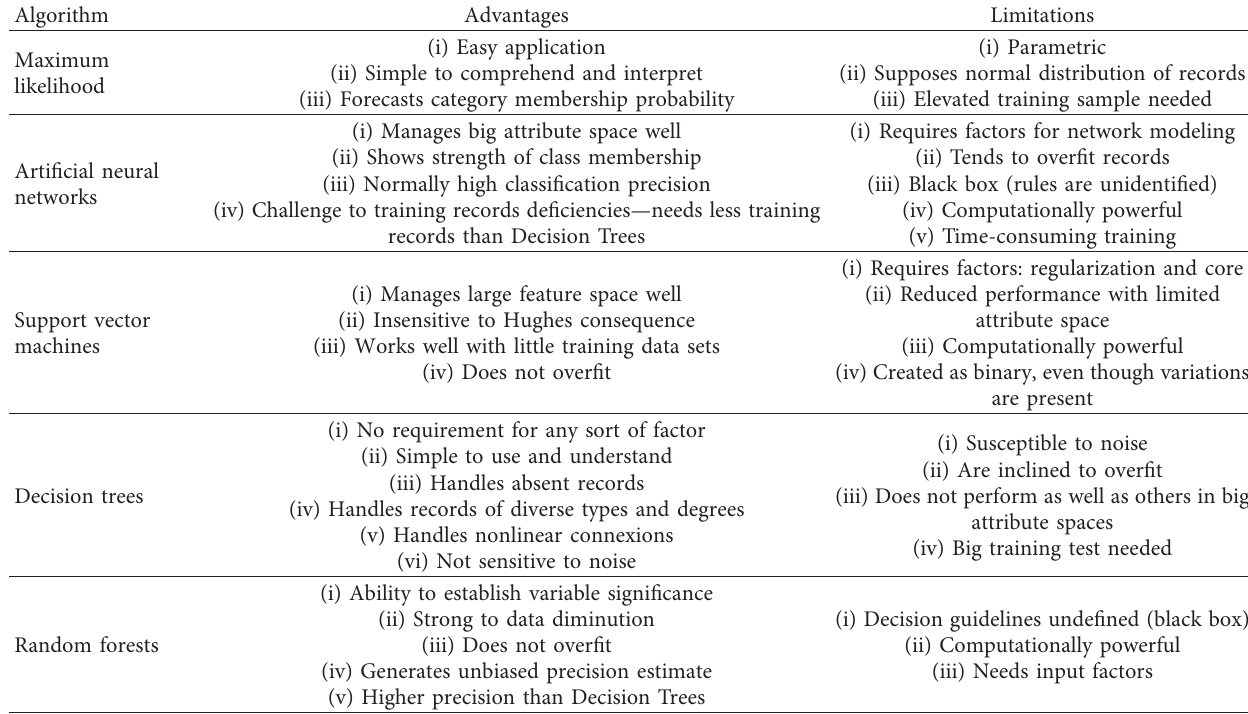
Table 3: Advantages and limitations of algorithms employed for wide-area classification of satellite picture records [147].